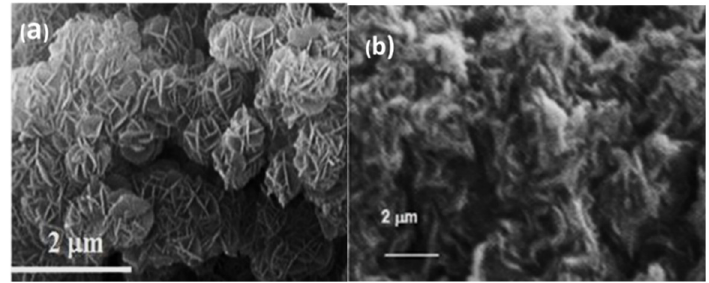
Figure 3. SEM photographs of the adsorbents: ( a ) MgAlCO3 and ( b ) Mg2AlDBS.